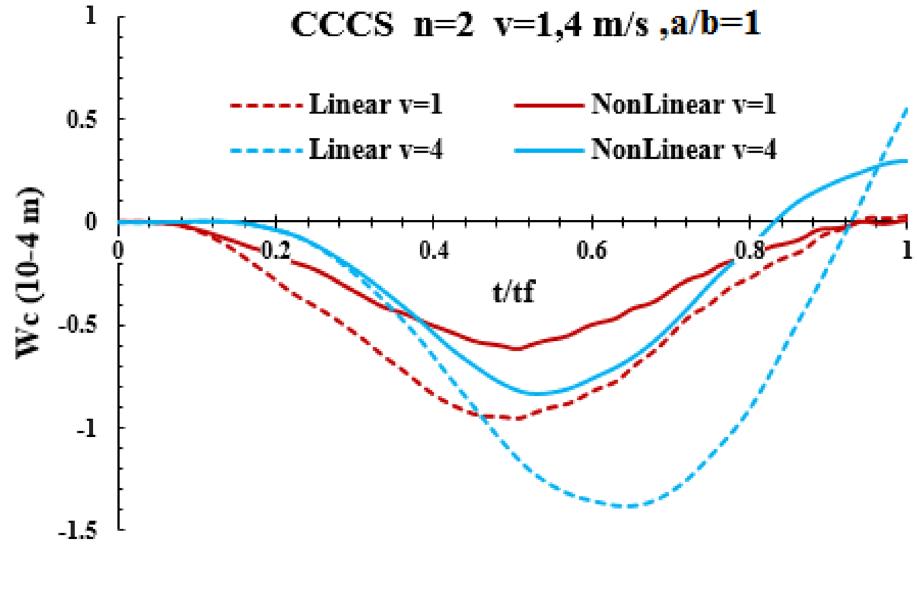
Fig. 8 The effect of velocity of moving force on deflection history of center-point of the plate (SSSS boundary condi-